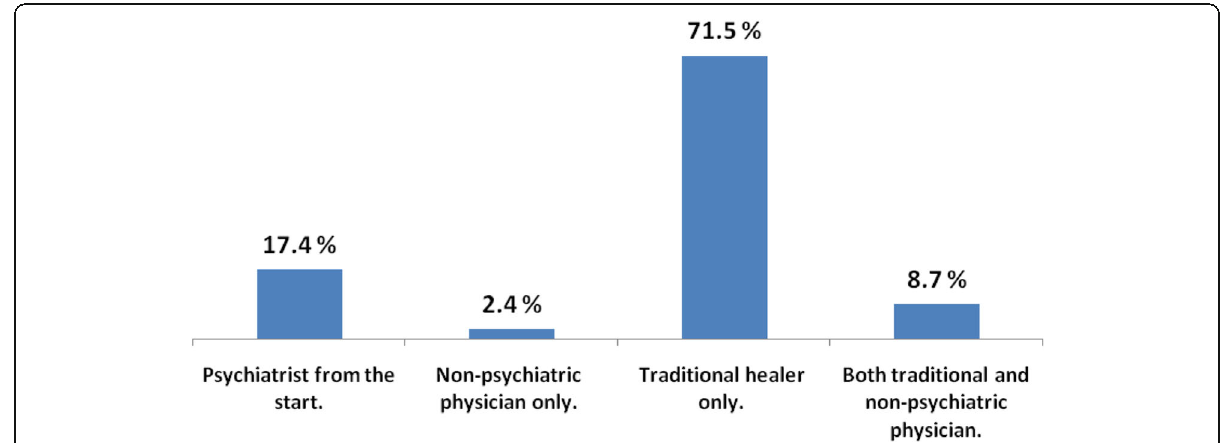
Fig. 1 Type of the earliest sought care of the studied caregivers for their patients, Assiut University Hospitals